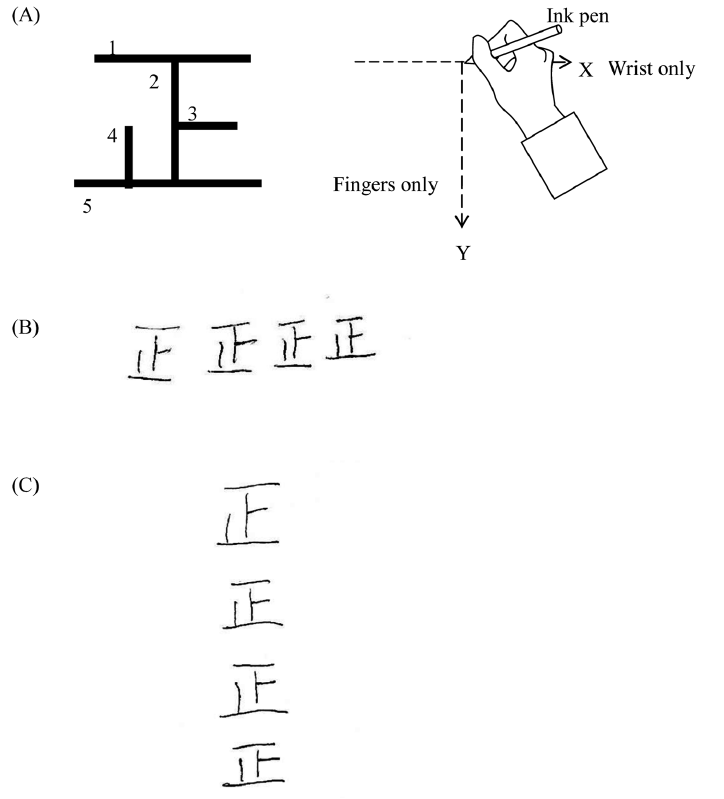
Fig. 1. (A) An illustration of the stroke order for writing “ ” and movements for writing the strokes (wrist extension for the horizontal strokes and fi nger fl exion for the vertical strokes). (B) A sample of horizontal writing from a person with Parkinson’s disease (PD#01). (C) A sample of vertical writing from a person with Parkinson’s disease